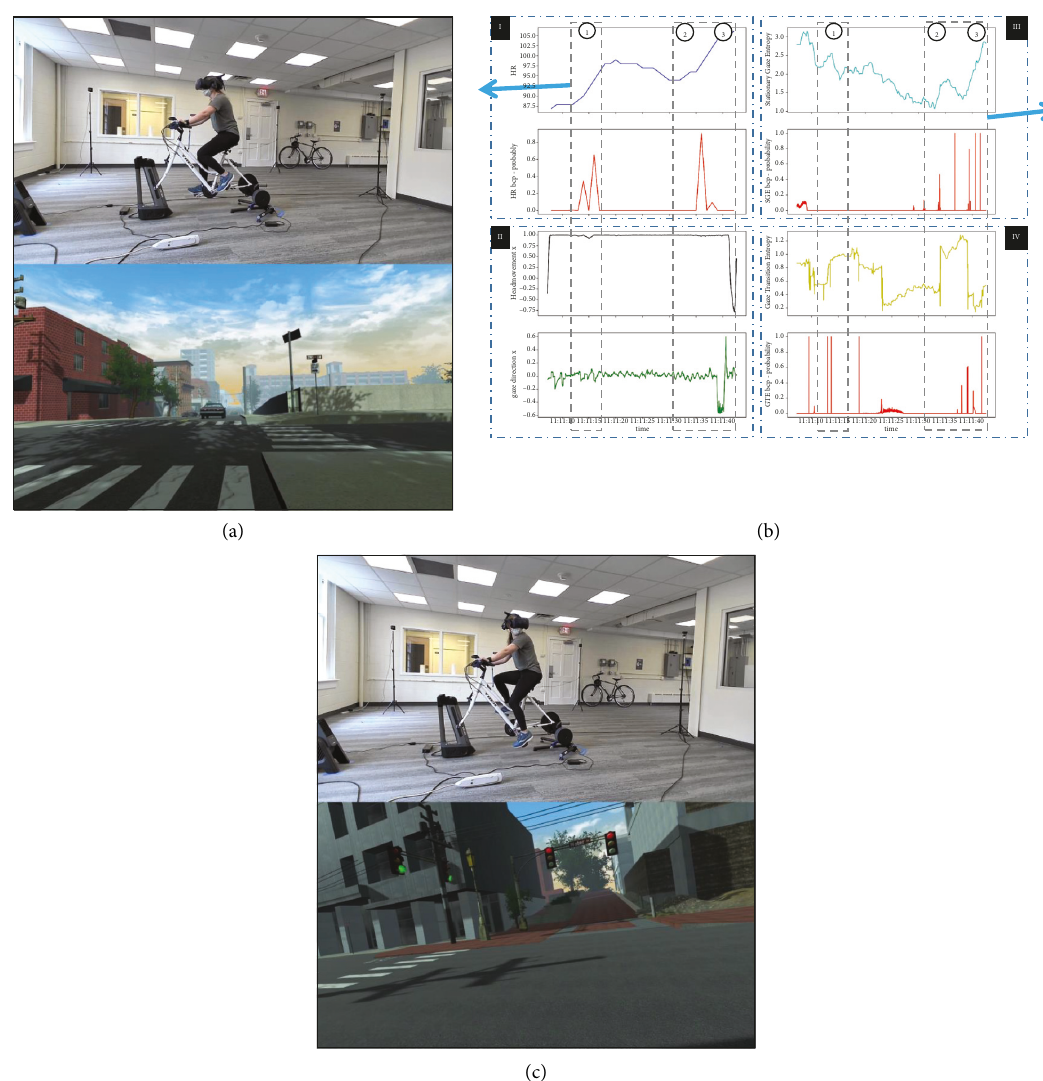
Figure 5: Bicyclist’s HR change point analysis over time with other physiological responses. (a) Video snapshot of HR change point event 1. The bicyclist is approaching the intersection. (b) Visualizations of different physiological data. I: HR (blue) and HR BCP probability (red); II: horizontal head movement direction (black) and horizontal gaze direction (green); III: stationary gaze entropy (SGE) (cyan) and SGE BCP probability (red); IV: gaze transition entropy (GTE) (yellow) and GTE BCP probability (red). (c) Video snapshot of HR change point event 2. The bicyclist looked left behind to check if cars are approaching from